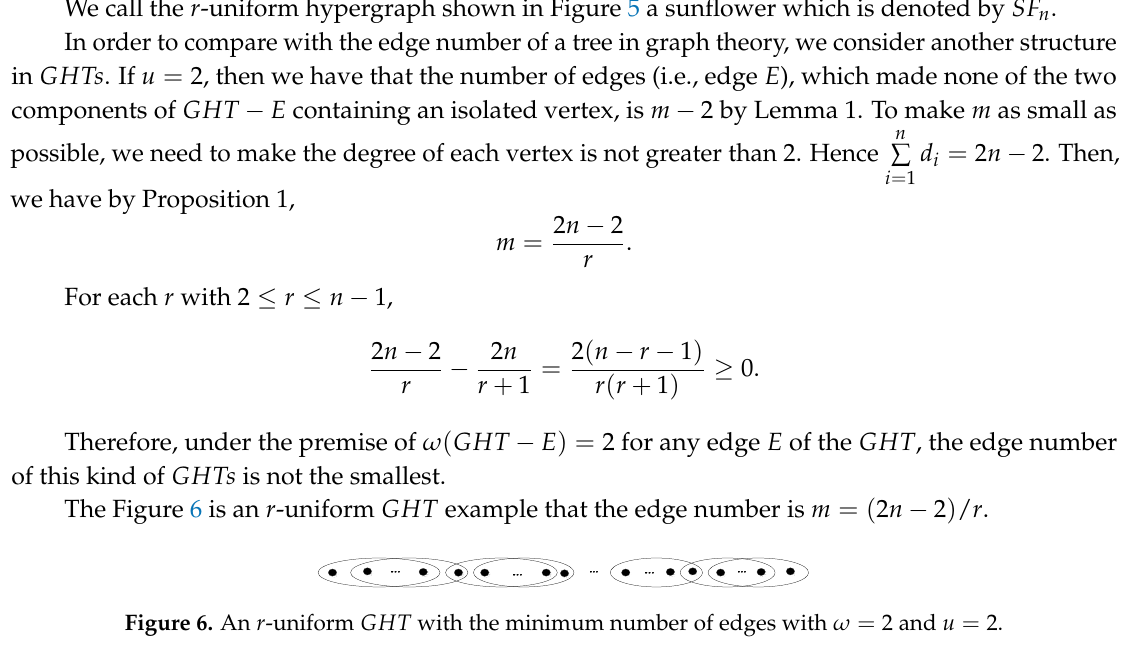
Figure 5. An r ‐ uniform GHT with the maximum number of edges with ω = 2 and u = m .